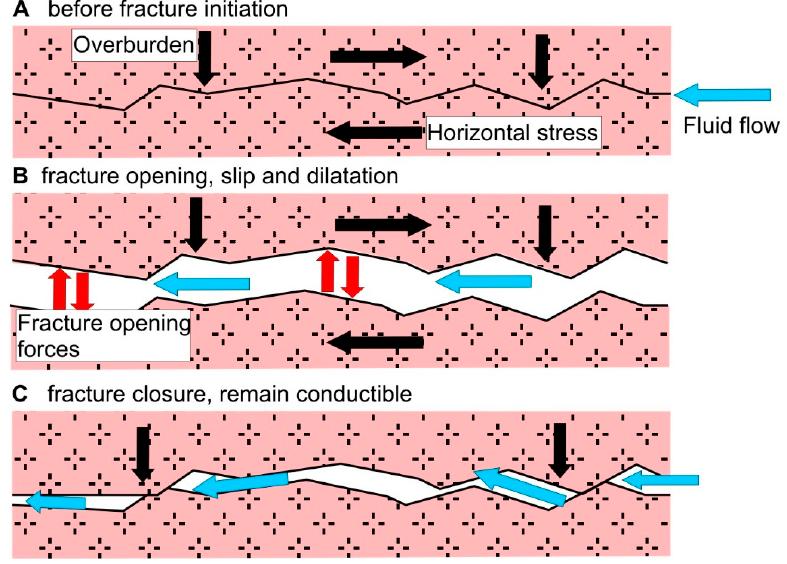
Figure 3. Basic principles of hydroshearing. Blue arrows depict fluid flow, black—principal stress directions, red—fracture opening forces.